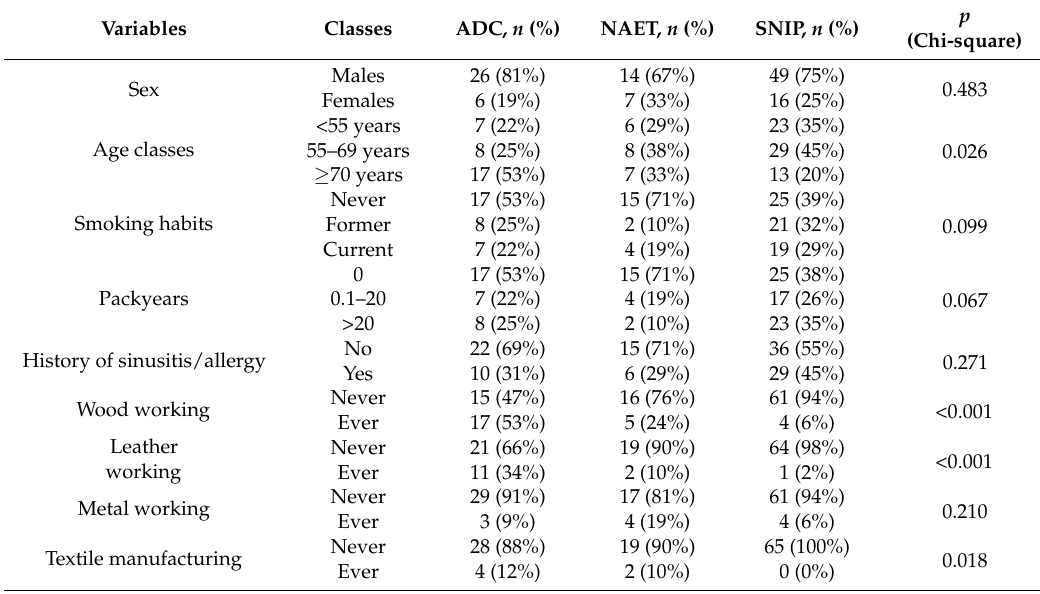
Table 1. Distribution of study variables among cases with adenocarcinoma (ADC, n = 32) or non-adenocarcinoma epithelial tumor (NAET, n = 21), and controls with sinonasal inverted papilloma (SNIP, n =